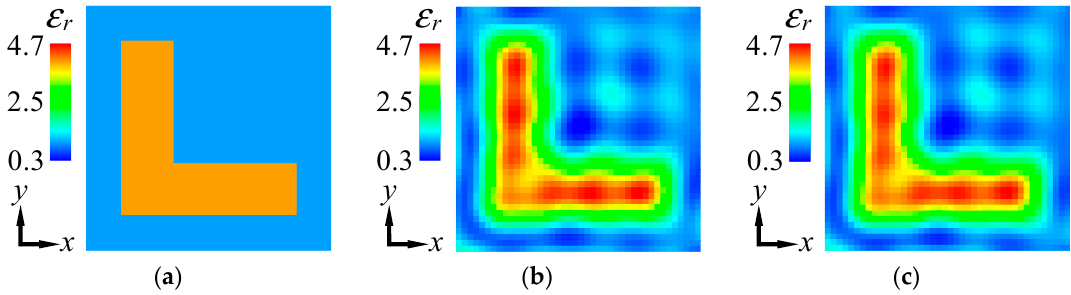
Figure 12. Reconstruction results for the square object after 50 iterations: ( a ) true image, ( b ) reconstructed image using information on the exact incident field, and ( c ) reconstructed image using information on the extracted incident field.